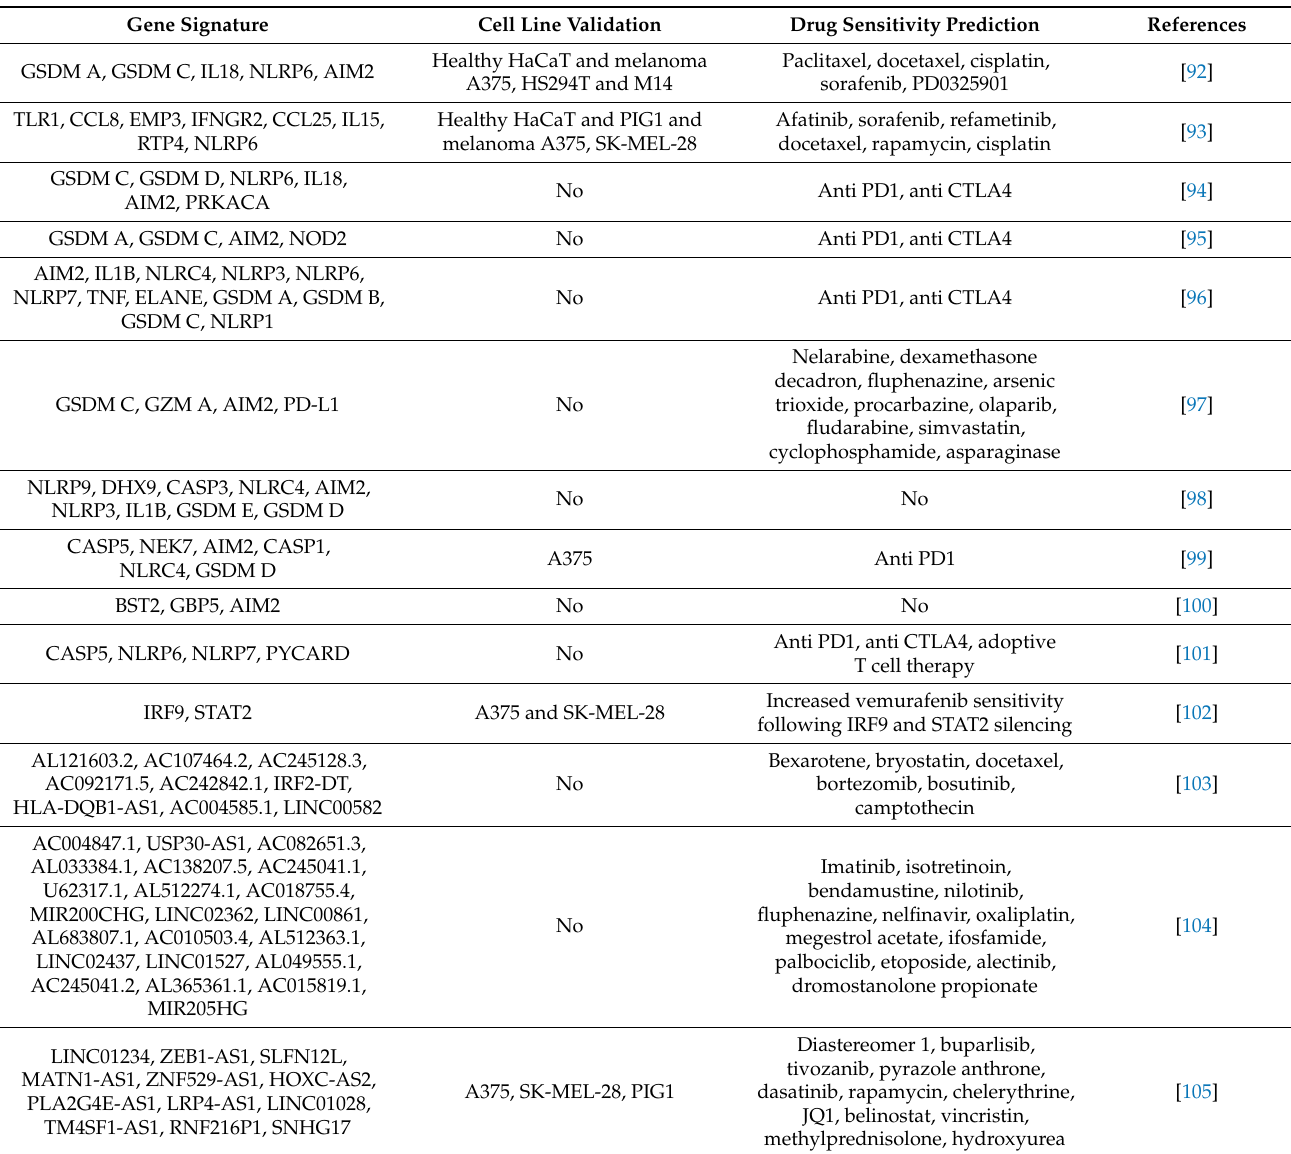
Table 2. Gene signatures reflecting pyroptosis in